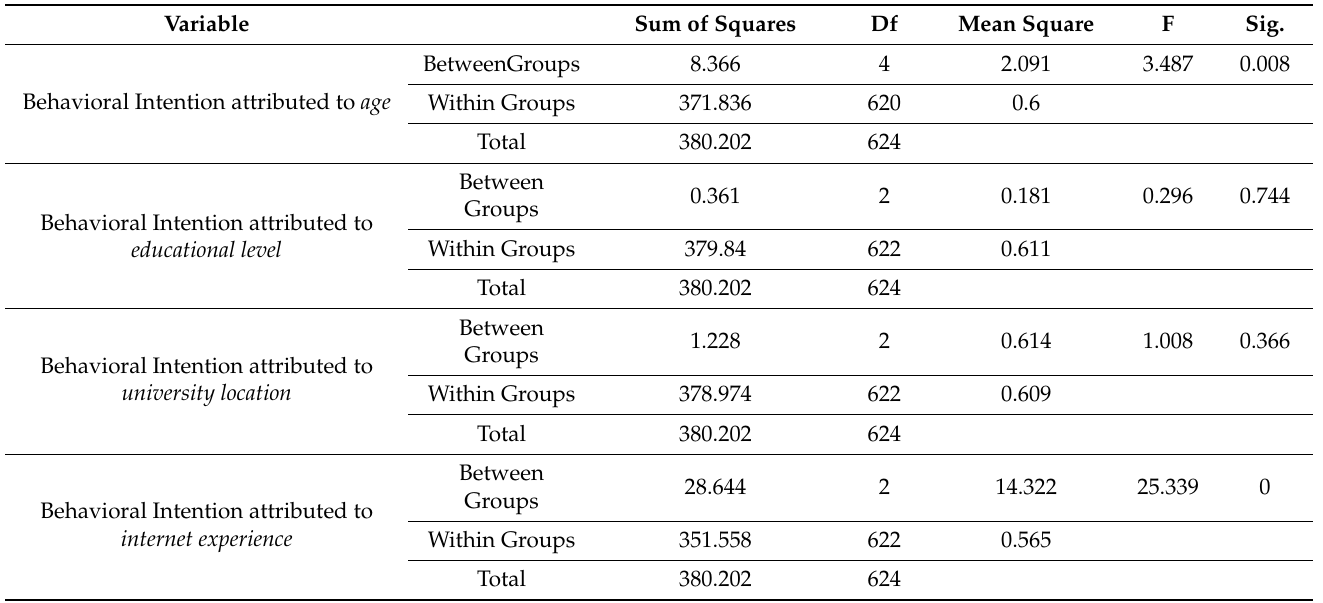
Table 9. ANOVA analysis of respondent behavioral intention attributed to age, education, university location, and internet